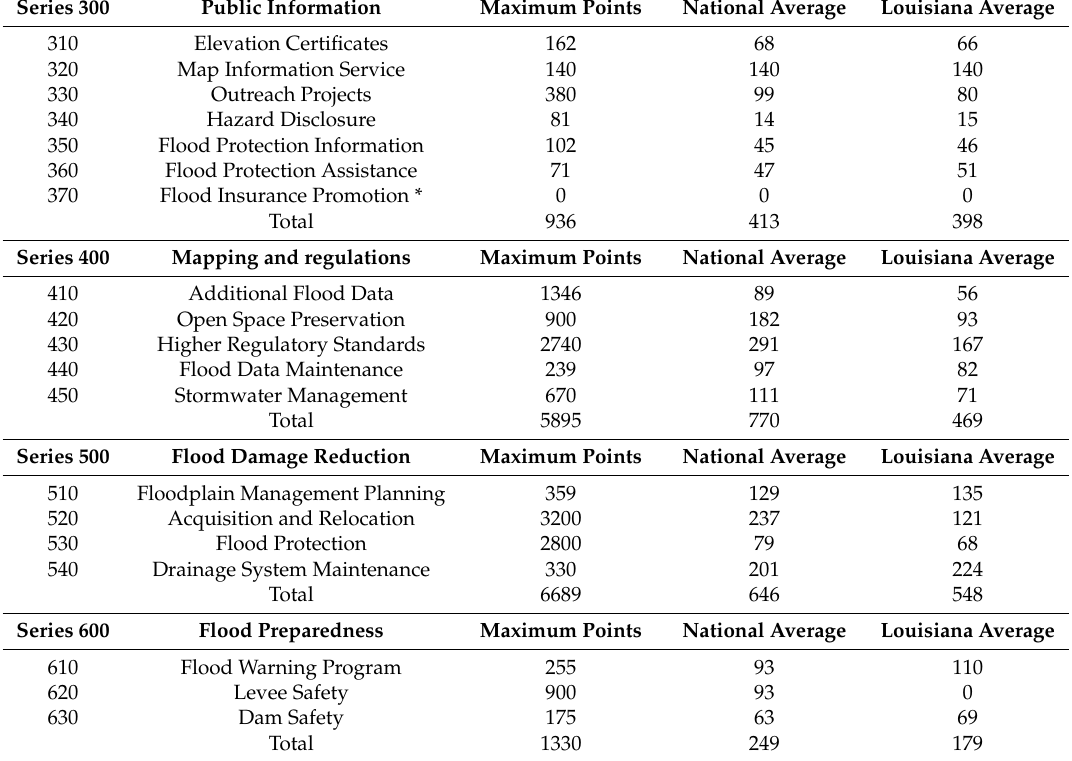
Table 1. The Community Rating System (CRS) activities and credit point system